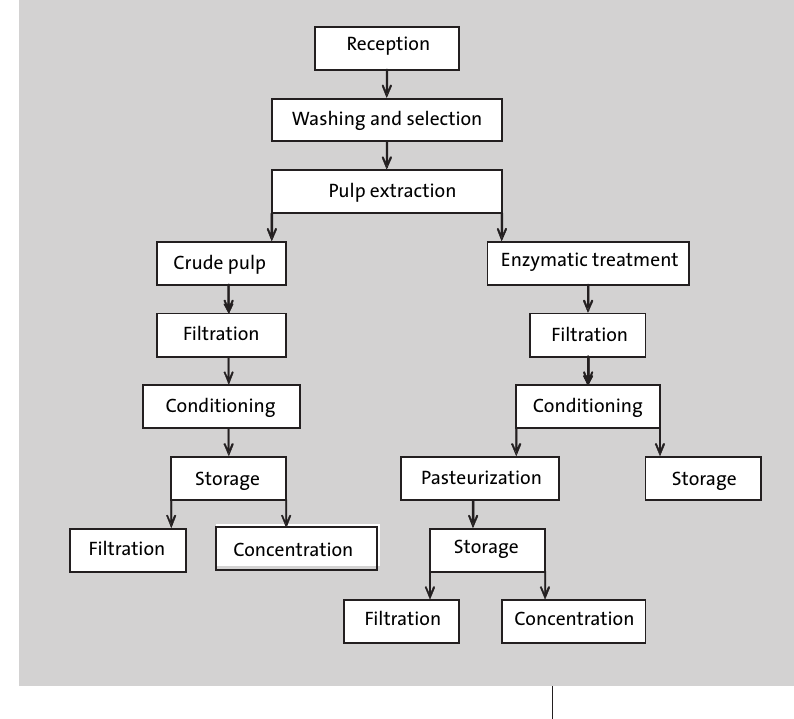
Figure 1: Schema of the star fruit pulp